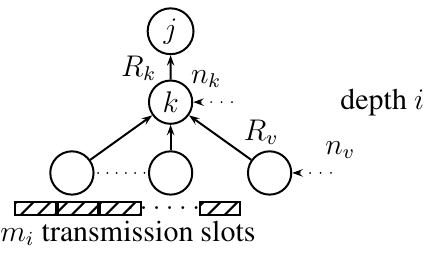
Figure 6. Communication rate calculation for node k at tree depth i